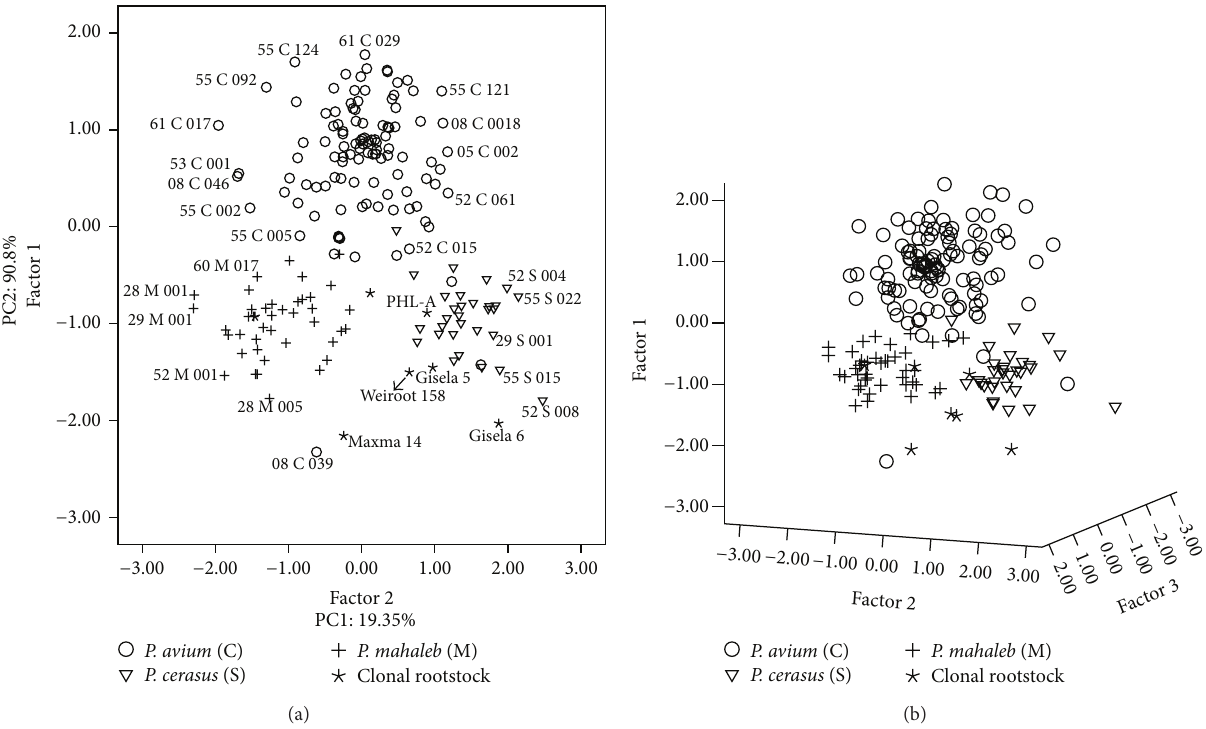
Figure 3: 2D and 3D scatter diagrams of the relationships between the genotypes/clonal rootstocks (based on morphological traits).